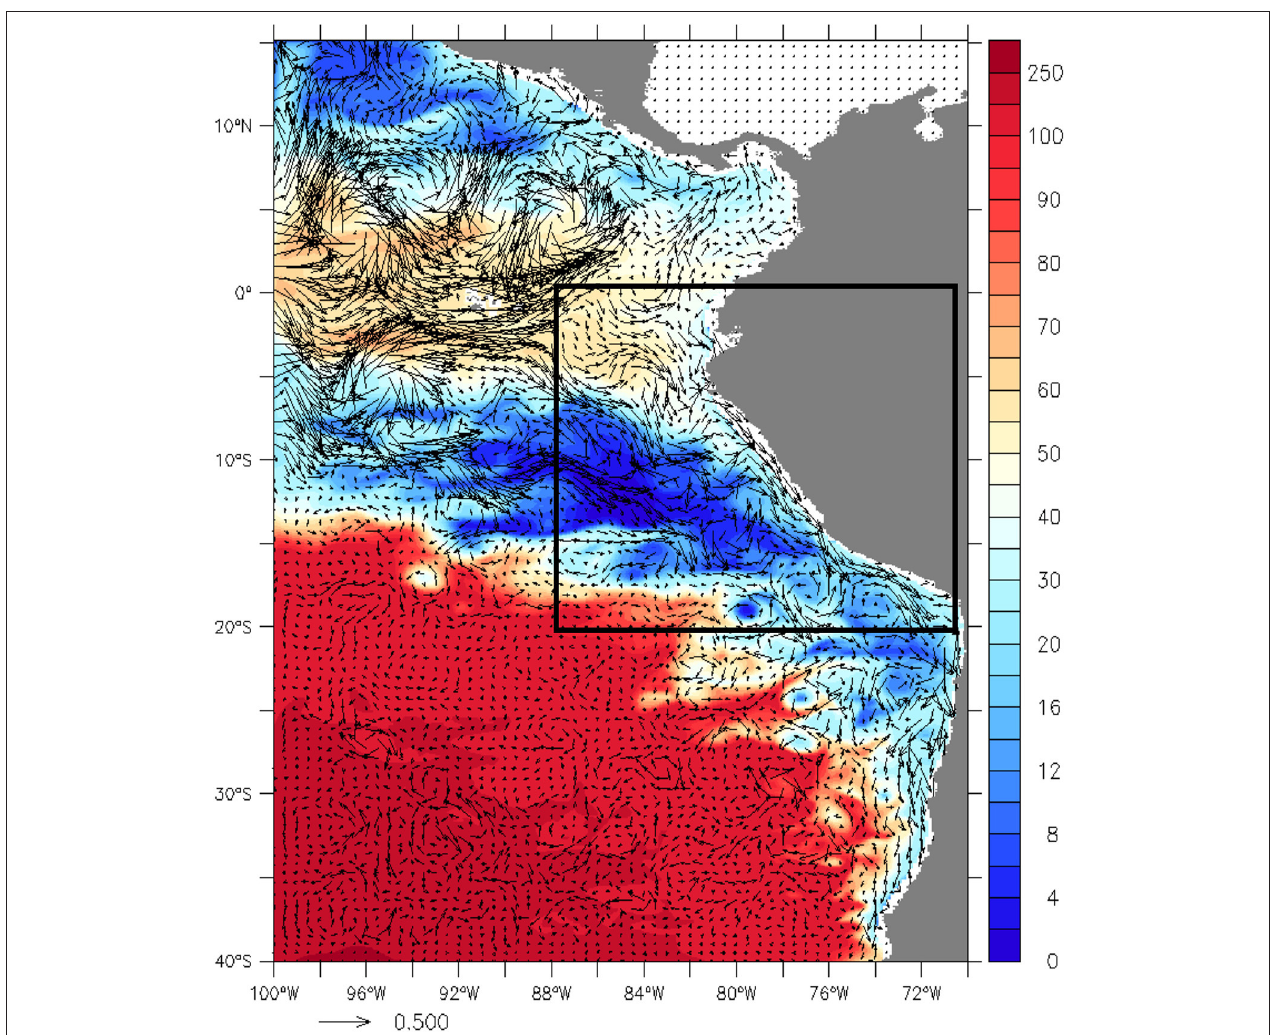
FIGURE 1 | Modeled Velocity current (arrows, in m s − 1 ) and DO mean (color scale, µ mol kg − 1 ) between 200 and 300m depth during December 1997–March 1998. The black box marks the studied area. contrasted atmospheric and open boundary forcing to